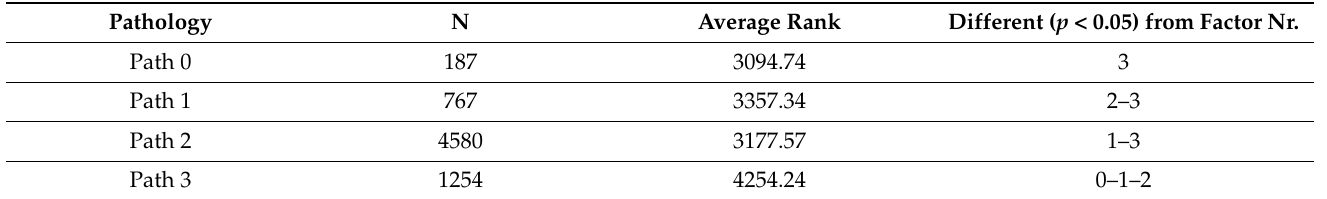
Table 5. Post hoc analysis (Conover) of adenocarcinomas and epidermoid carcinomas.